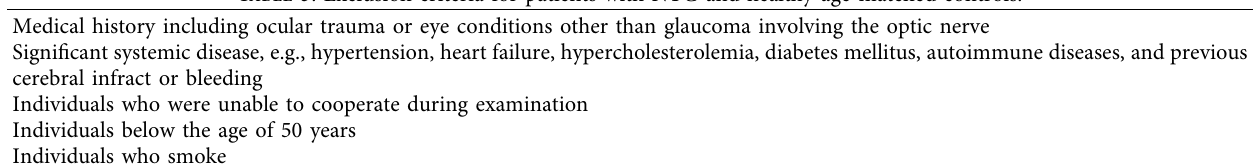
Table 3: Exclusion criteria for patients with NTG and healthy age-matched